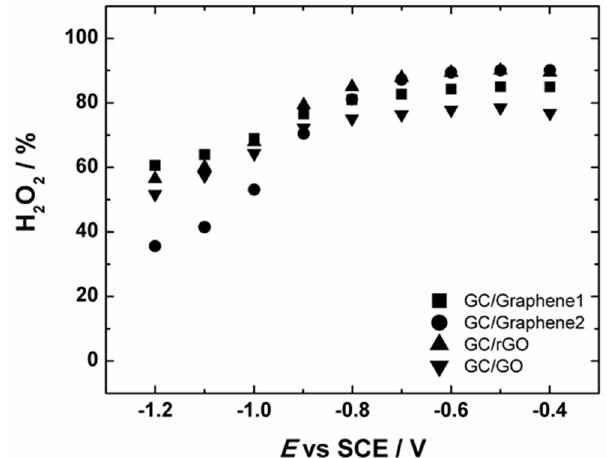
Figure 8. The potential dependence of the yield of peroxide formation on GC electrodes modified with graphene nanopowder from Graphene Supermarket (GC/Graphene1), graphene nanoplatelet aggregates from Strem Chemicals (GC/Graphene2), reduced graphene oxide (GC/rGO) and graphene oxide (GC/GO) in O 2 ‐ saturated 0.1 M KOH. For GC electrode modification the catalyst ink suspension in 2 ‐ propanol containing OH − ionomer was used.